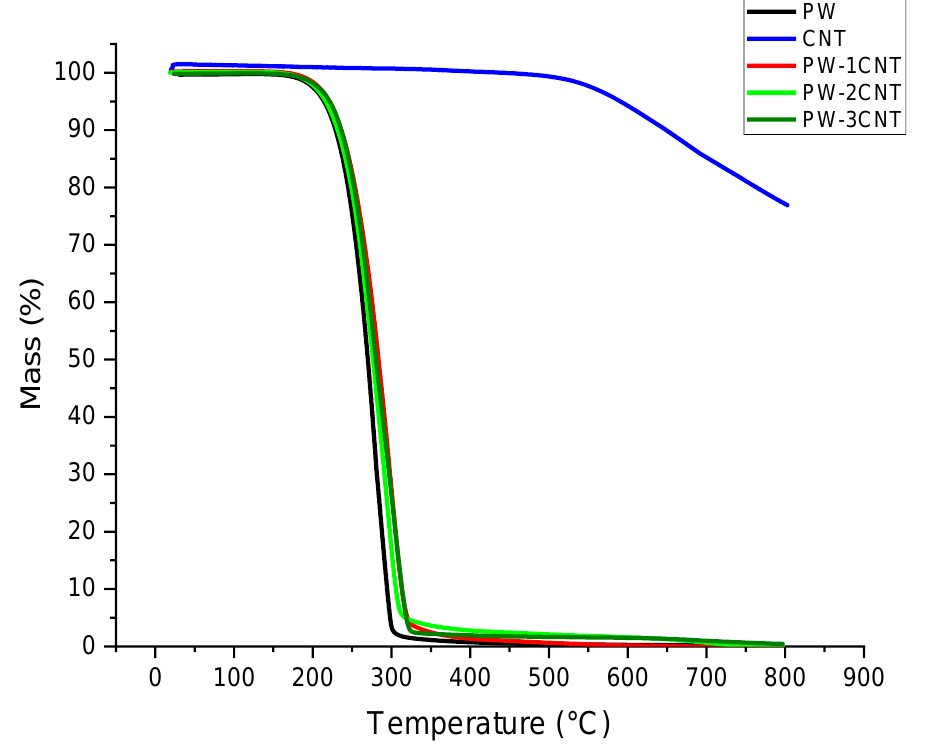
Figure 7. TGA thermogram of the paraffin wax/MWCNT and composites (PW-1CNT, PW-2CNT, and PW-3CNT). Table 4. Mass loss of the PW, CNT, and composites 1, 2, and 3.